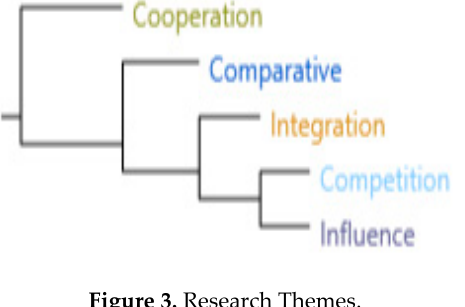
Figure 3. Research Themes. Table 1. Pearson Correlation Coefficients for Research Theme. Node